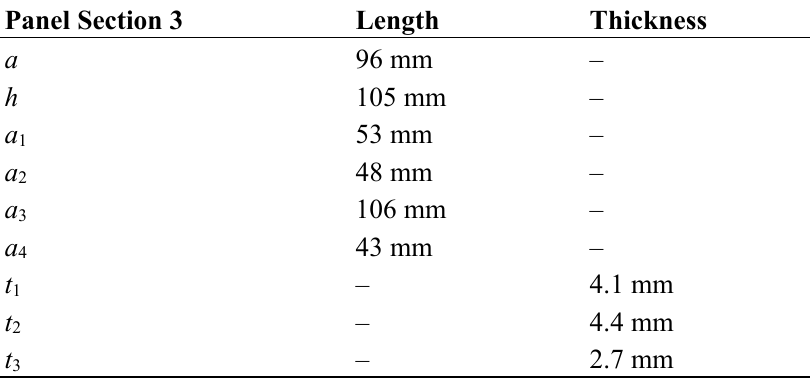
Table 6. Dimensions of optimized Panel Section 3 (see Figure 2 for an explanation).